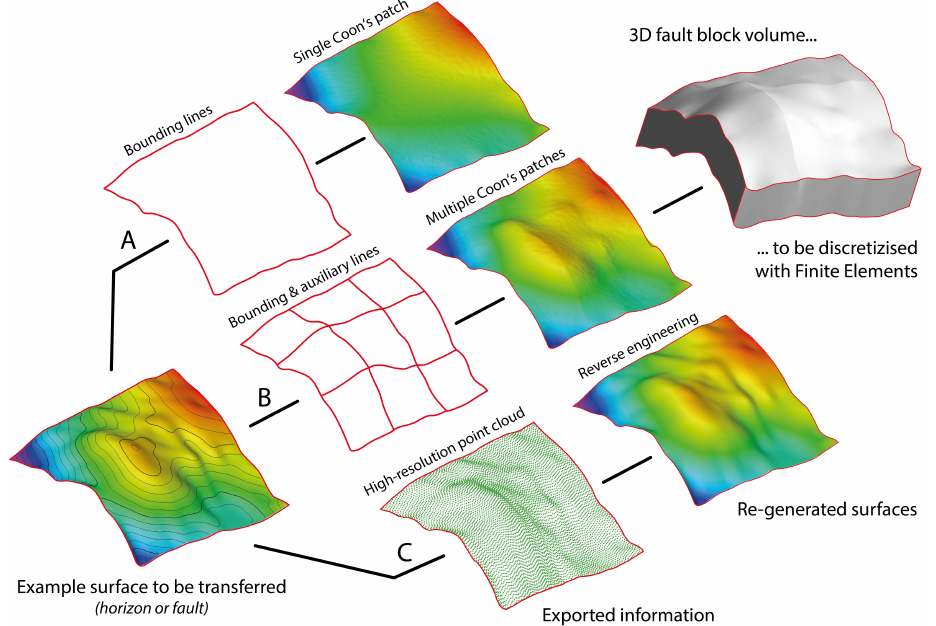
Fig. 2. Illustration of the three options for the transfer of an arbitrary surface from a geological subsurface model to the finite element model. (A) If bounding lines are used exclusively to create a Coon’s patch, only little internal topological information is preserved in the regenerated surface. (B) By adding a network of auxiliary lines, the resulting Coon’s patches are significantly smaller and the internal topology can be preserved more accurately. (C) The most accurate option uses a different approach, i.e. a high-resolution point cloud and reverse engineering techniques for surface reproduction. This approach is by far the most labour-intensive approach and not suitable for field-scale